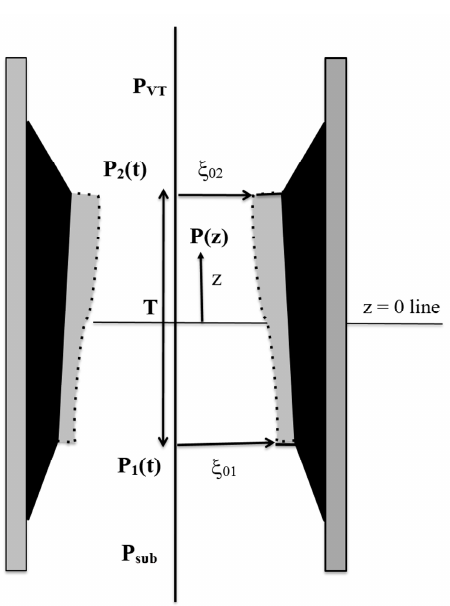
Figure 1. A schematic diagram showing the surface wave propagating along the medial surface of the vocal tract. The halfwidth at the glottal entrance is ξ 01 , and that at the glottal exit is ξ 02 .